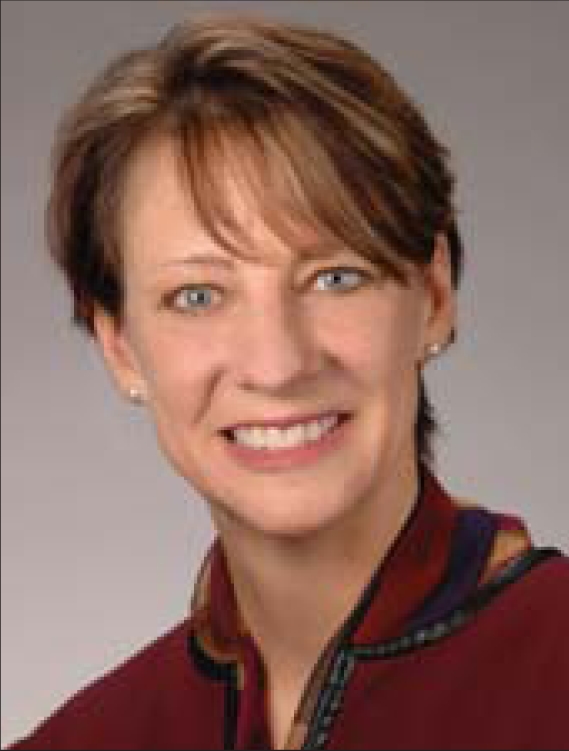
Sharon H. Hrynkow